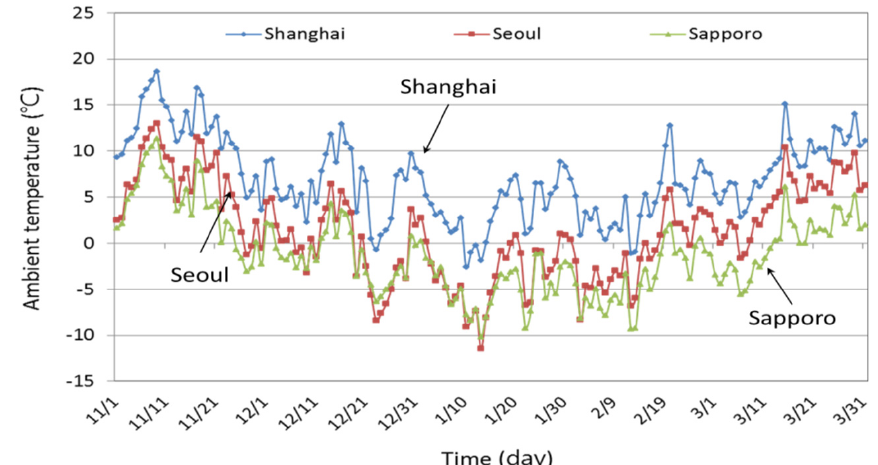
Figure 15. Ambient temperature of cities. Table 6. Simulation results with different weather conditions.